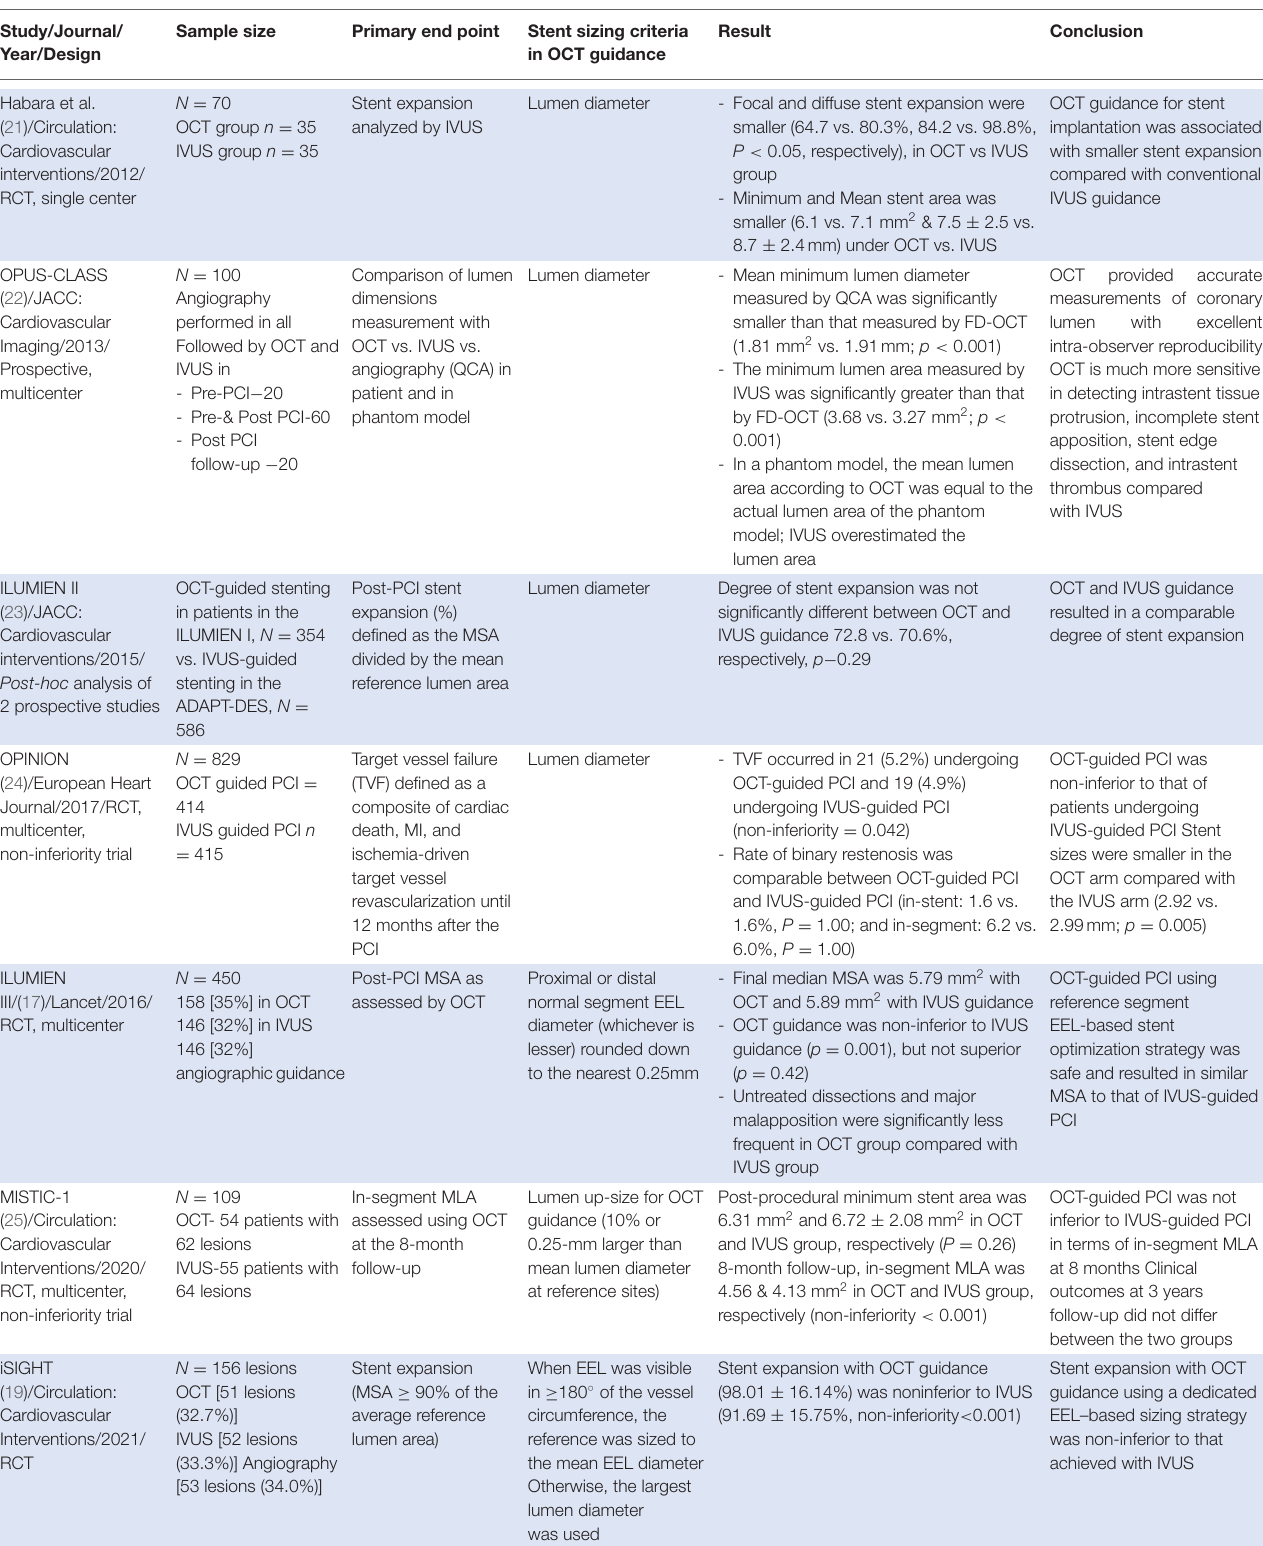
TABLE 3 | Studies performed for a comparison between OCT and IVUS for PCI